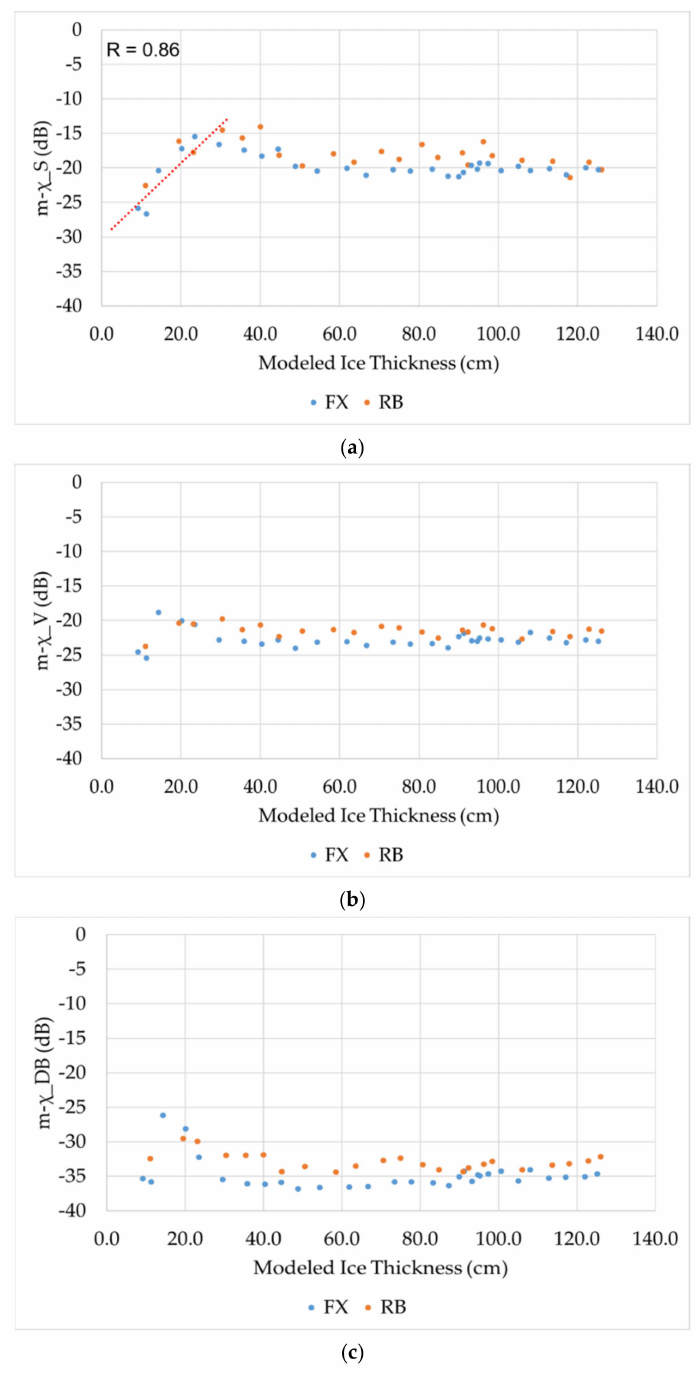
Figure 5. Temporal evolution of ( a ) surface scattering, ( b ) volume scattering, and ( c ) double-bounce scattering from m- χ decomposition. Red trend line is included for values in the range sensitive to ice thickness. R is the correlation coe ffi cient of linearly regressed